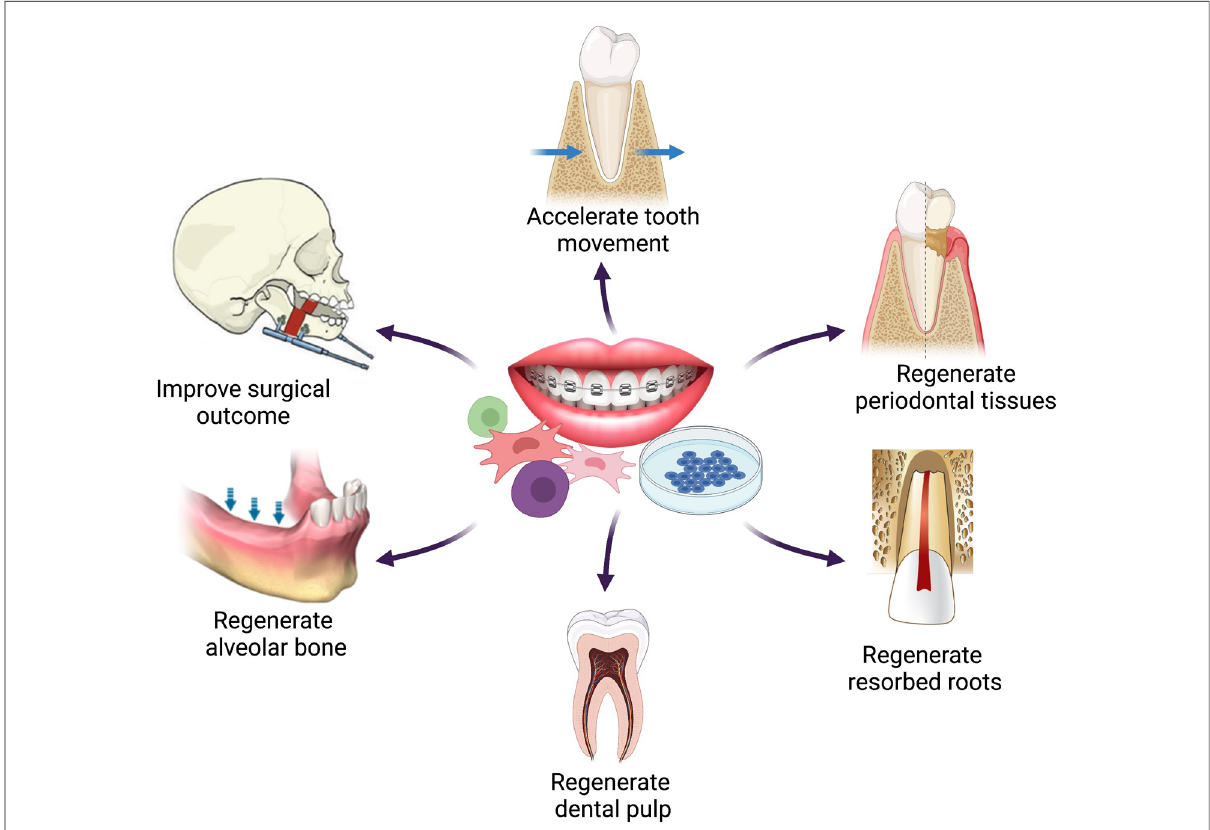
FIGURE 1 Schematic representation of the six themes of potential applications of regenerative techniques in adult orthodontics. Figure created with